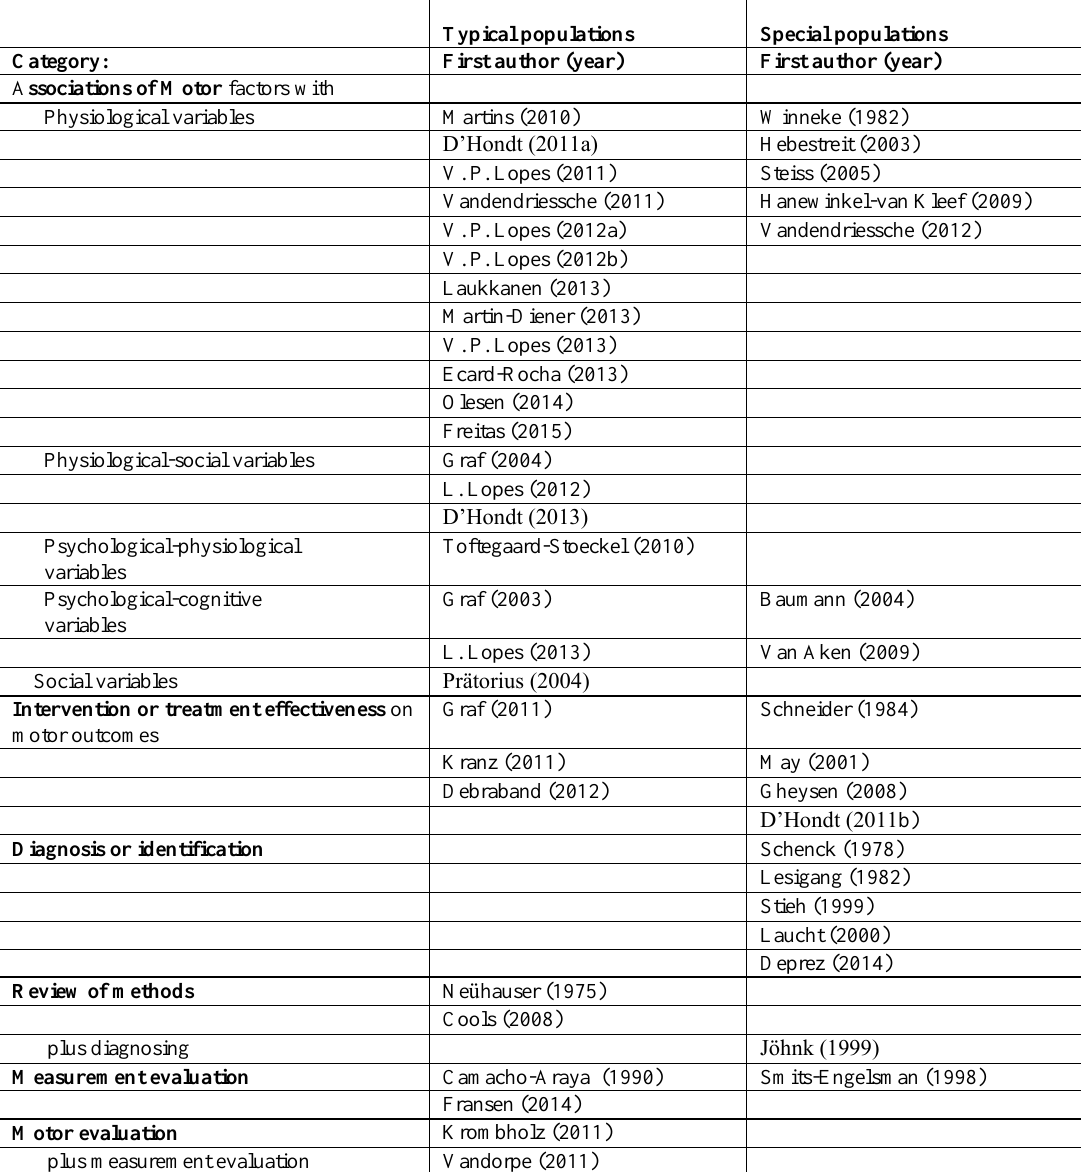
Table 2. Categorization of articles according to their main purposes and the use of the Körperkoordinationstest für